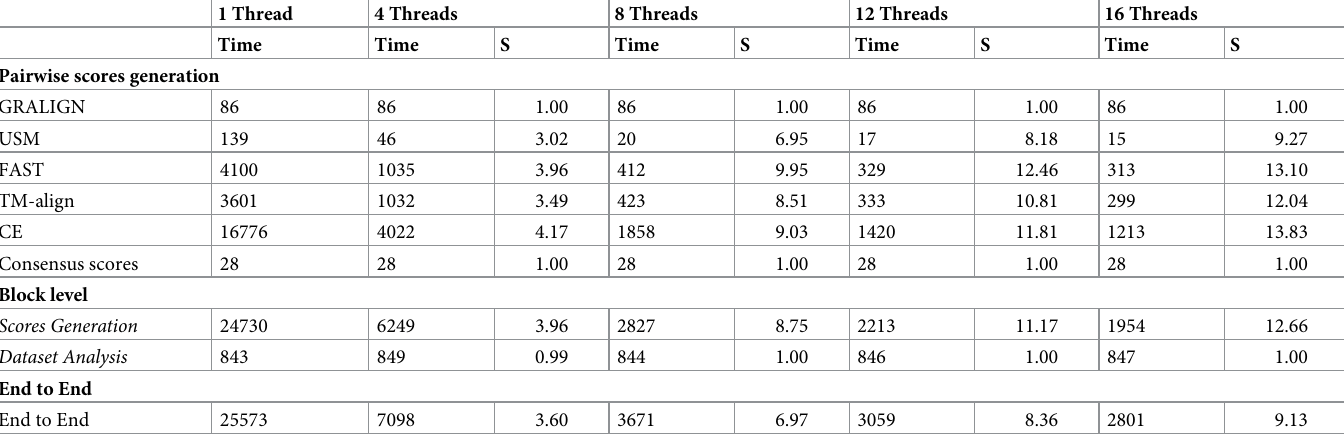
Table 2. Time (in seconds) and Speedup (S) for end-to-end all-to-all analysis of the Proteus_300 dataset using pyMCPSC on a multi-core PC with Intel i7 CPU hav- ing 8 cores (16 threads), 32 GB RAM, running at 3.0 GHz, under Ubuntu 14.04 Linux. GRALIGN already uses all the CPU cores by default.